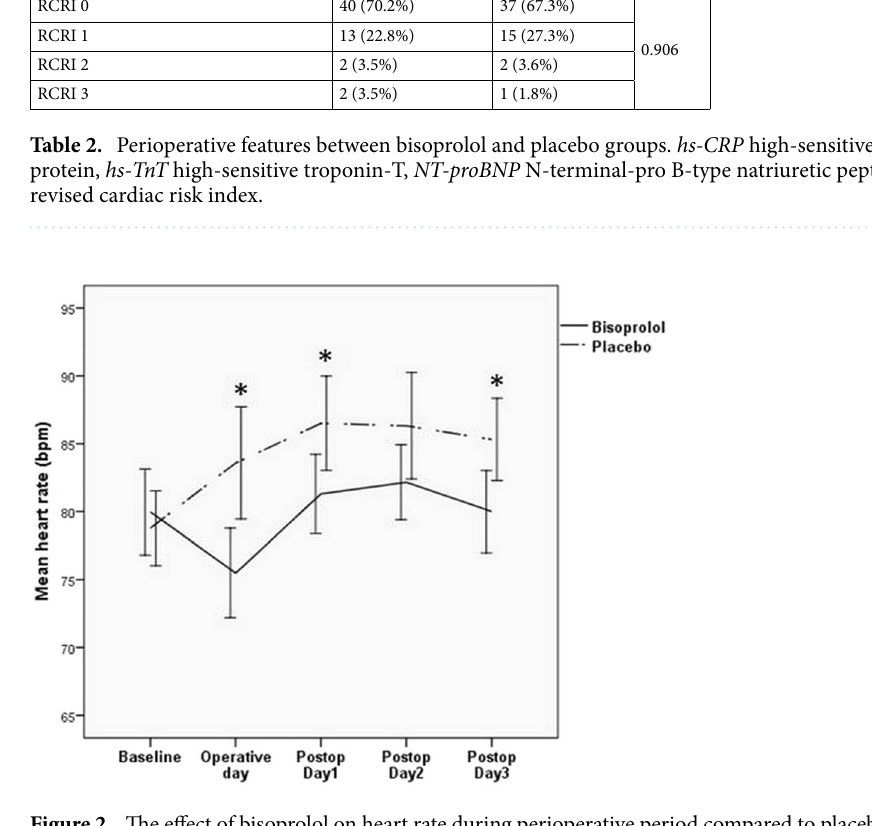
Figure 2. The effect of bisoprolol on heart rate during perioperative period compared to placebo. Among patient receiving bisoprolol (solid line), the mean heart rate was significantly reduced on operative day compared to baseline. It then significantly increased after surgery. On the contrary, in patients receiving placebo (dashed line), the mean heart rate increased on the operative day, the continued to increase after surgery. The heart rate on operative day and postoperative day 1–3 was significantly lower in bisoprolol group. *Statistically significant P < 0.05, compared to